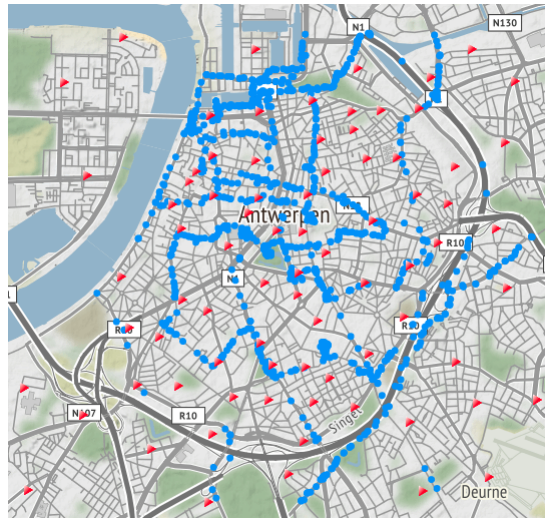
Figure 2. Map of the 53km 2 test environment in the city of Antwerp, Belgium, used to study the localization accuracy. The 1307 blue dots represent the GPS locations of the transmitter where a message was sent, while the 83 red triangles indicate the eNB locations.